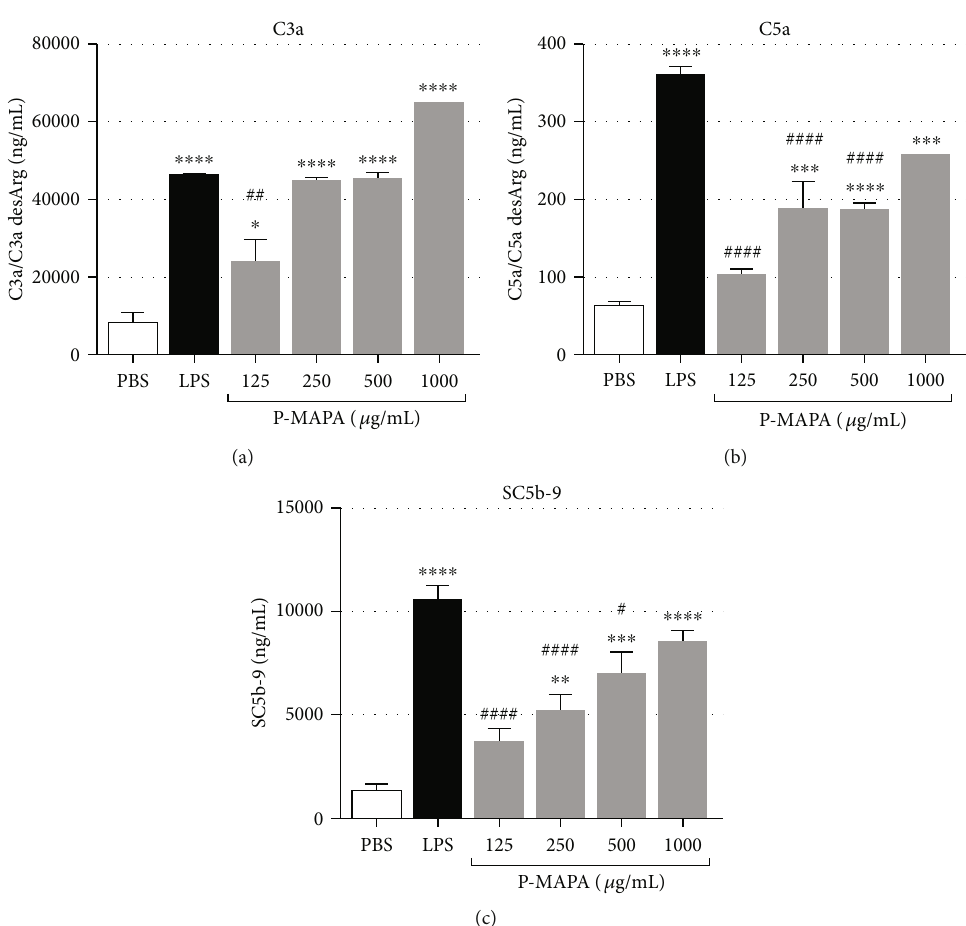
Figure 1: Activation of the complement system by P-MAPA in human whole blood. Complement activation products were measured in plasma from blood samples (720 μ L) incubated with PBS, LPS (100 μ g/mL), or increasing concentrations of P-MAPA, at 37 ° C for 30 minutes. (a) Levels of C3a/C3a desArg in plasma, posttreatment, were measured using the OptEIA Human C3a ELISA Kit or BD CBA Anaphylatoxin Kit. (b) Levels of C5a/C5a desArg were measured using the OptEIA Human C5a ELISA or BD CBA Anaphylatoxin Kit. (c) sC5b-9 complex levels in plasma, following incubation with P-MAPA, were measured by EIA detection kit. Data are the mean of three independent experiments, from three di ff erent blood donors, performed in duplicate, and the results are expressed as the mean ± SEM . Statistical analysis was performed by one- way ANOVA, complemented with the Tukey test. ∗ p < 0 : 05 , ∗∗ p < 0 : 01 , ∗∗∗ p < 0 : 001 , and ∗∗∗∗ p < 0 : 0001 : signi fi cant di ff erences between the mean values with PBS control. # p < 0 : 05 , ## p < 0 : 01 , ### p < 0 : 001 , and #### p < 0 : 0001 : signi fi cant di ff erences between the mean values with